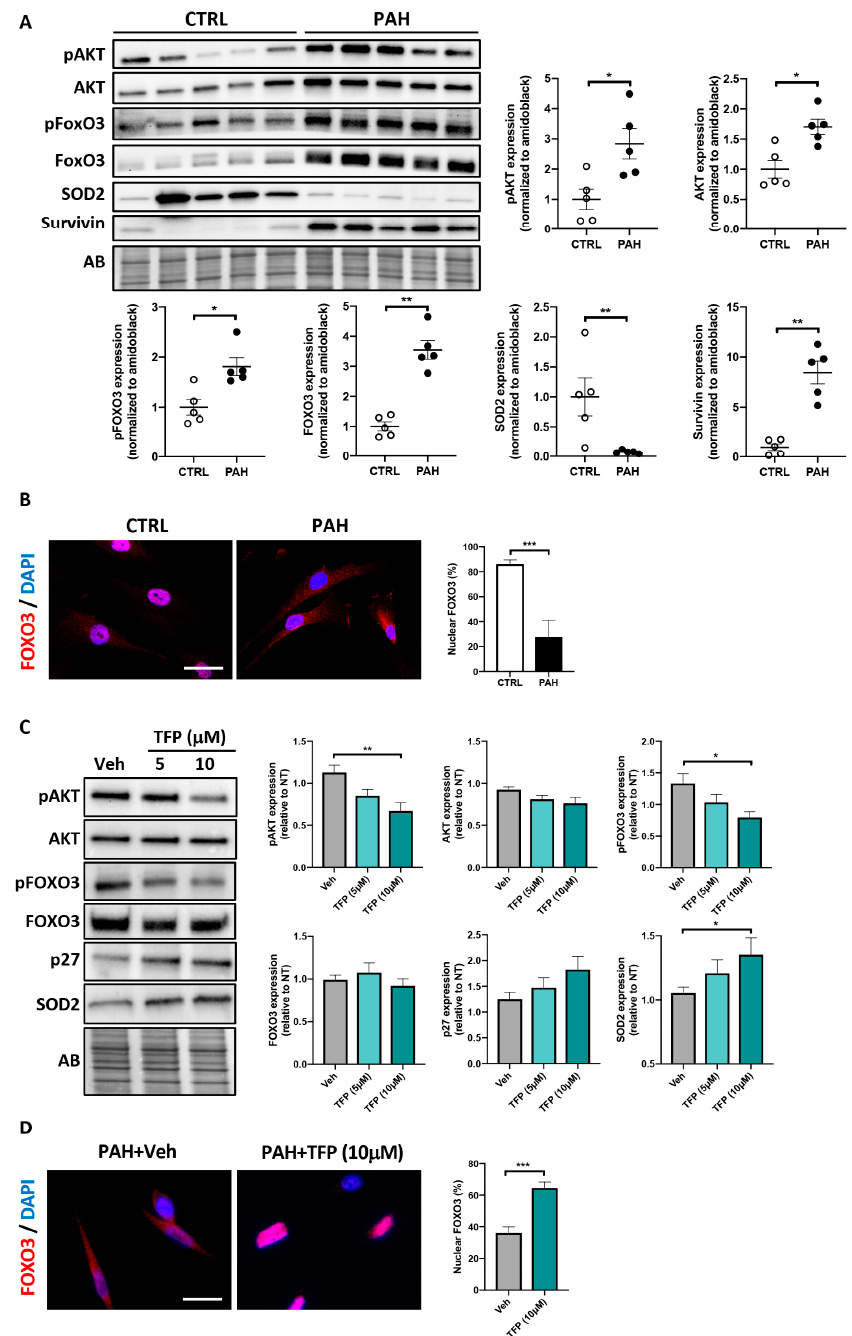
Figure 2. Trifluoperazine (TFP) inhibits AKT activity, leading to nuclear translocation of forkhead box protein O3 (FOXO3). ( A ) Representative Western blots and corresponding densitometric analyses of p(Ser473)-AKT, AKT, p(Ser253)-FOXO3, FOXO3, superoxide dismutase 2 (SOD2) and Survivin in PASMCs isolated from control ( n = 5) and PAH ( n = 5) patients. ( B ) Representative immunofluorescence images for subcellular localization of FOXO3 in cultured control and PAH-PASMCs. Quantification of the percentage of cells exhibiting nuclear expression of FOXO3 is shown. ( C ) Representative Western blots and corresponding densitometric analyses of p(Ser473)-AKT, AKT, p(Ser253)-FOXO3, FOXO3, p27 and SOD2 in PAH-PASMCs ( n = 9) exposed or not to TFP for 24 h. Data are expressed as fold change relative to untreated cells. ( D ) Representative immunofluorescence images for subcellular localization of FOXO3 in PAH-PASMCs ( n = 9) exposed to TFP (10 µ M) or its vehicle for 24 h. Quantification of the percentage of cells exhibiting nuclear expression of FOXO3 is shown. Protein expression was normalized to Amido black (AB). * p < 0.05; ** p < 0.01 and *** p < 0.001. Scale bars: 20 µ